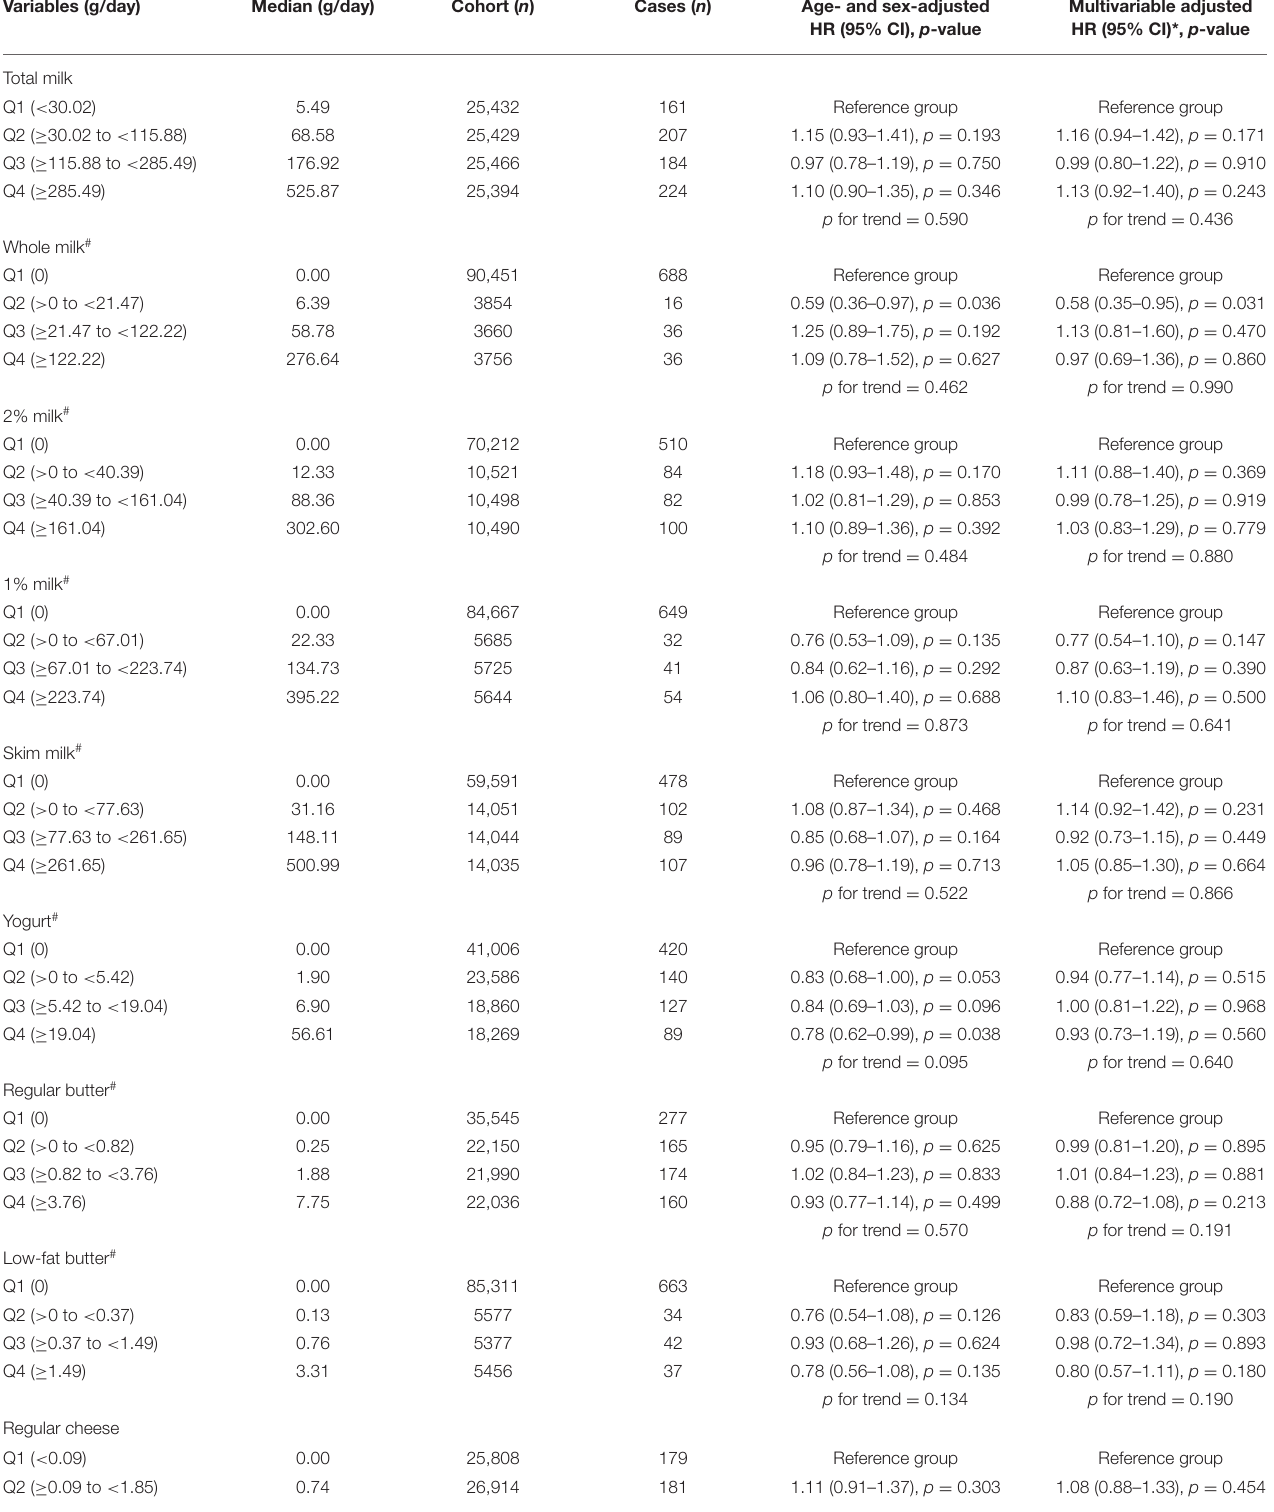
TABLE 2 | Association between intake of dairy products and bladder cancer risk in the PLCO cancer screening trial. Variables